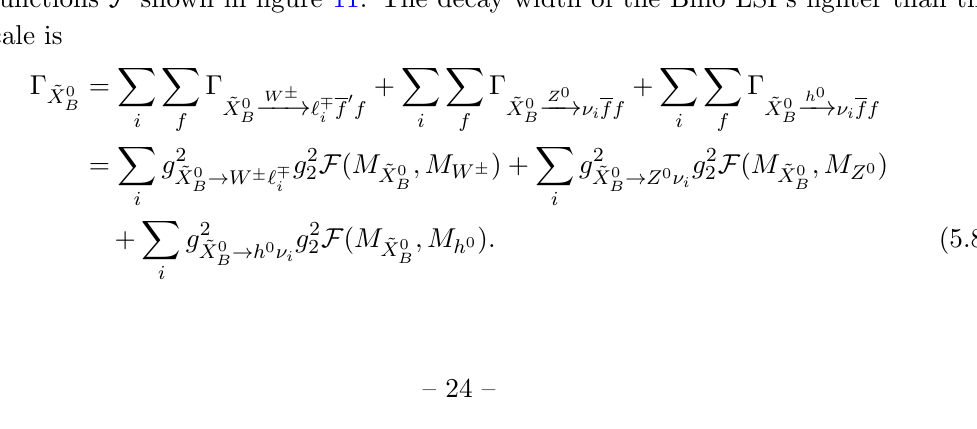
) de(cid:12)ned analagously to (5.6), after summing over all X 0 B